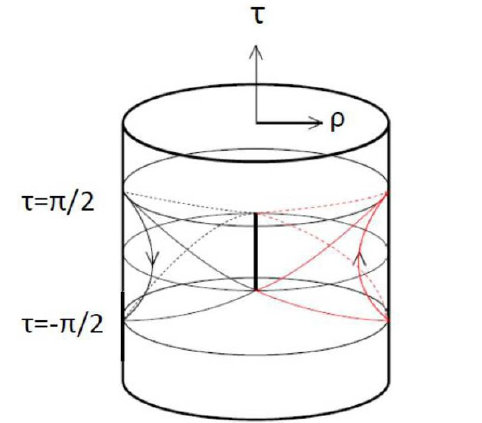
H d − 1 hypersurface. × π/ 2 at the boundary of ±